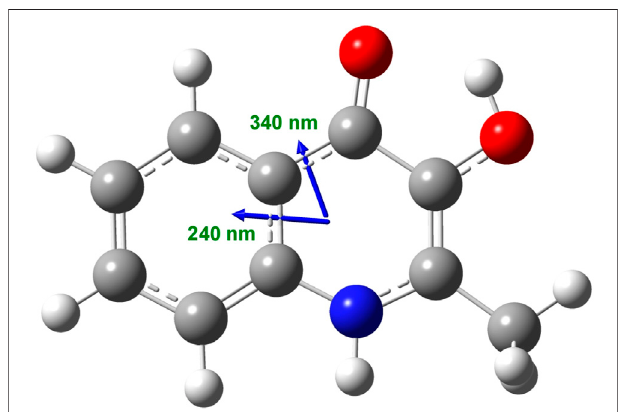
FIGURE 2 | Calculated direction of the π – π * electronic transition dipole moments in the aromatic segment of the PQS molecule coupled to the ∼ 240 and ∼ 340 nm excitations as obtained at the ω B97X-D/6-311++G (2d, 2p) level of